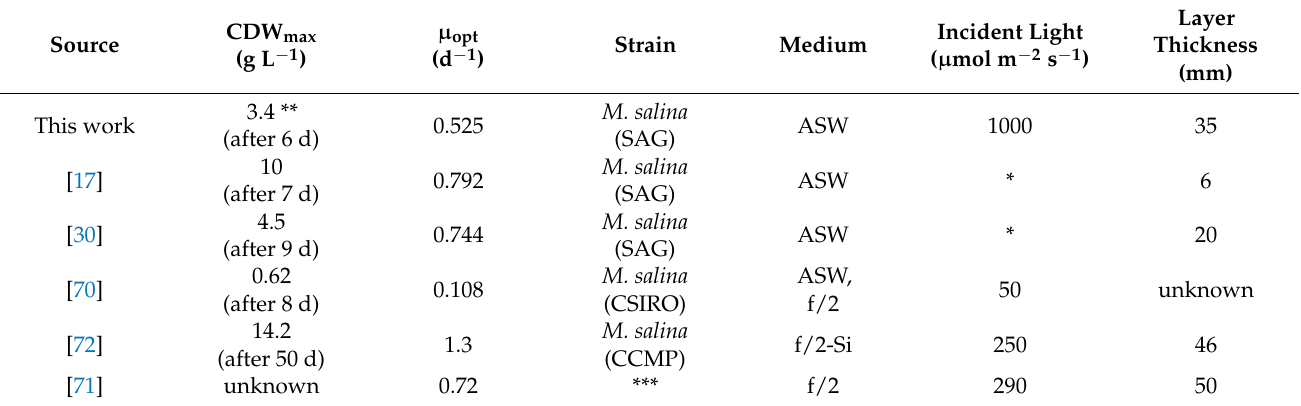
Table 1. Maximum growth rates observed ( µ opt ) and maximum dry cell weight (CDW max ) concentra- tions reported for M. salina in photoautotrophic batch cultivations at constant